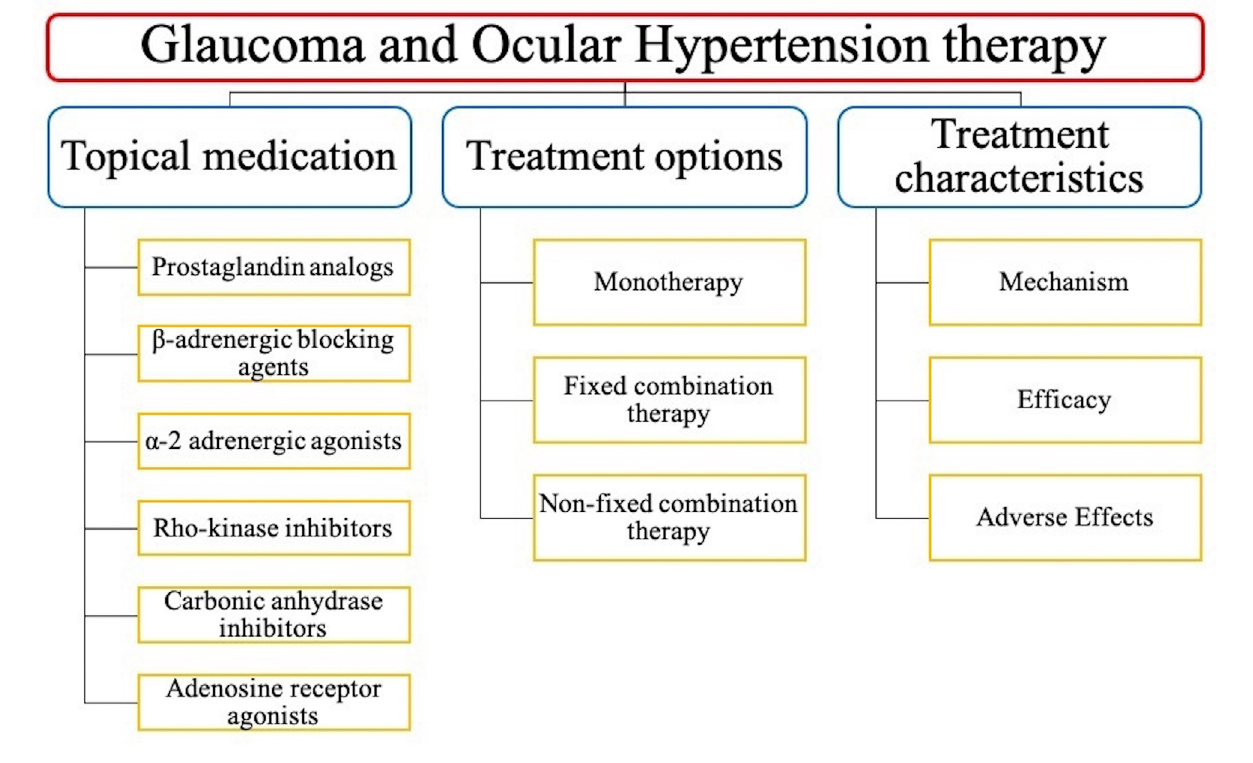
FIGURE 1 | The structure of this review.